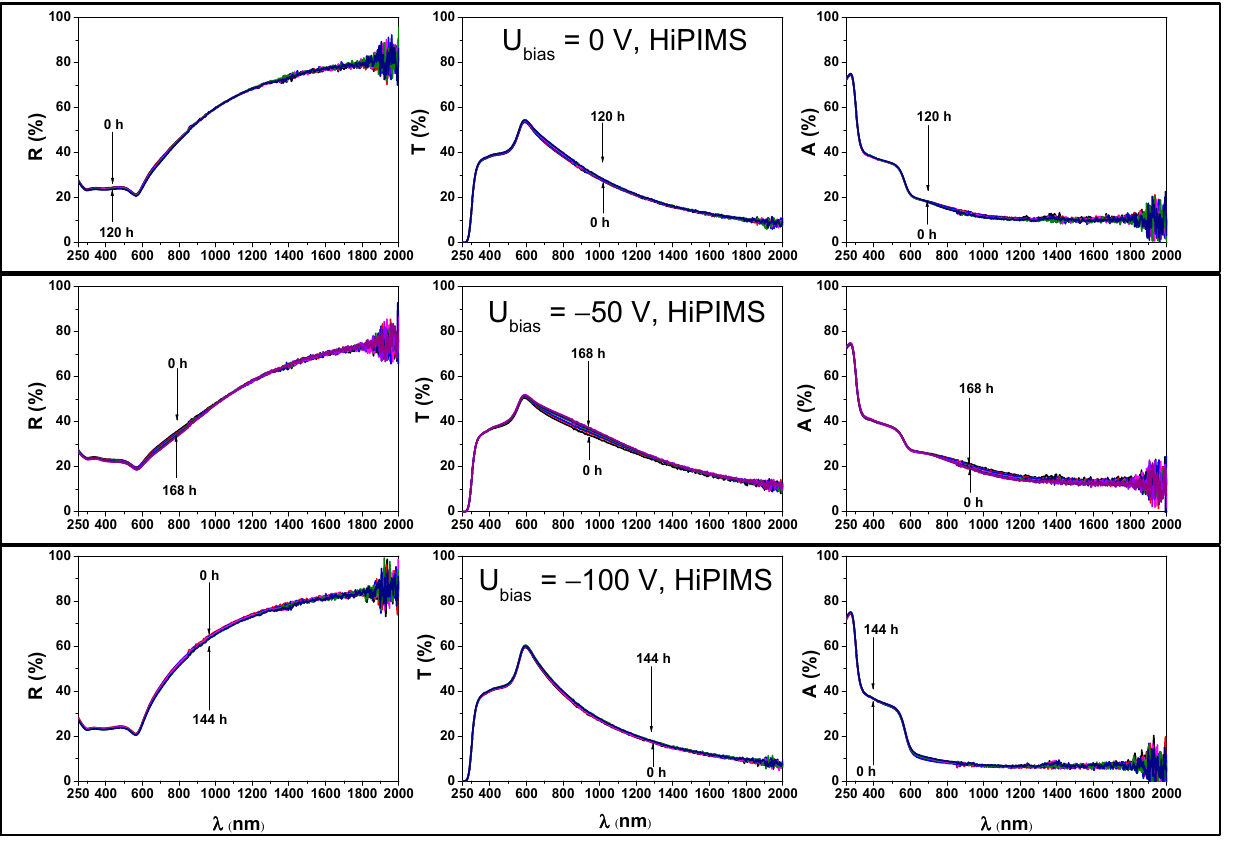
Figure 6. Experimental transmission, reflectance, and absorption spectra of copper films obtained immediately after the HiPIMS deposition process (0 h) and after several days exposure to atmospheric pressure conditions.